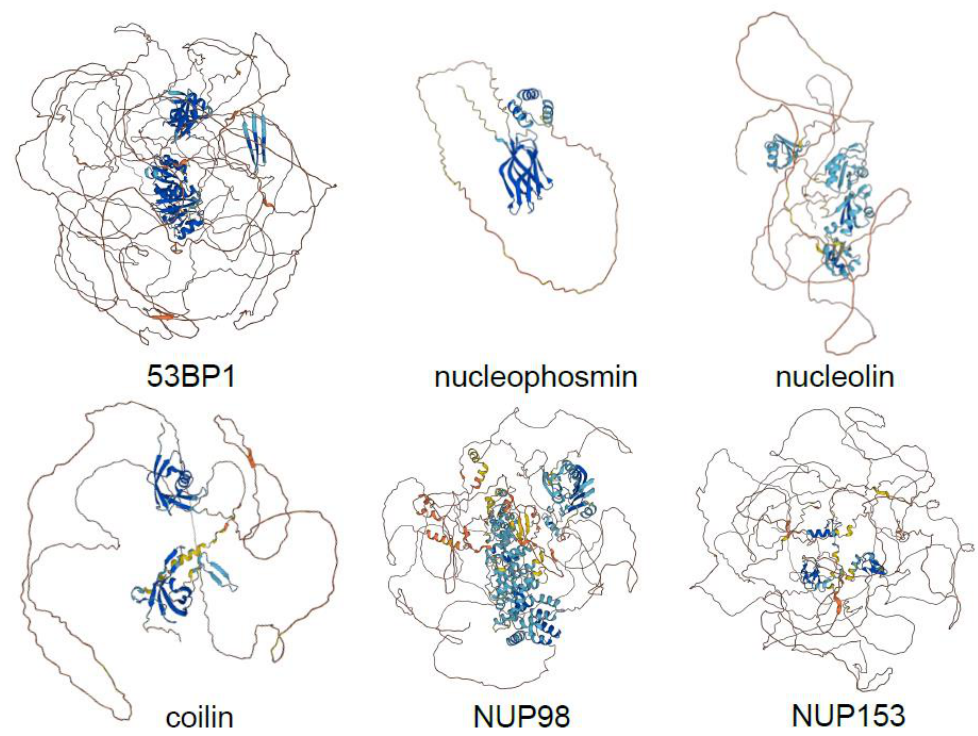
Figure 2. AlphaFold-predicted structures of exemplary IDPs and prominent MLO components that are CDK substrates (https://alphafold.ebi.ac.uk/) (accessed on 1 June 2022). This applies to CDKs. At the entry to mitosis, CDK1 phosphorylates many nucleo- porins (NUPs; [4]). NUPs form nuclear pores, structures responsible for selective bidirec- tional transport of molecules between the nucleus and the cytoplasm. A third of around